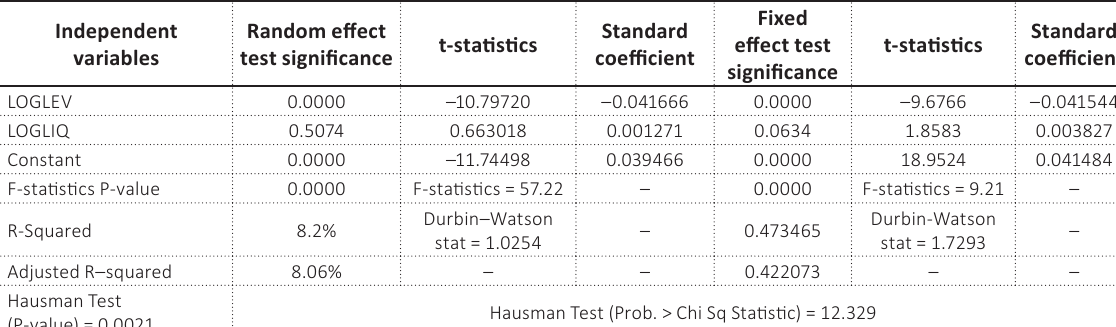
Table 1. Panel results for the main